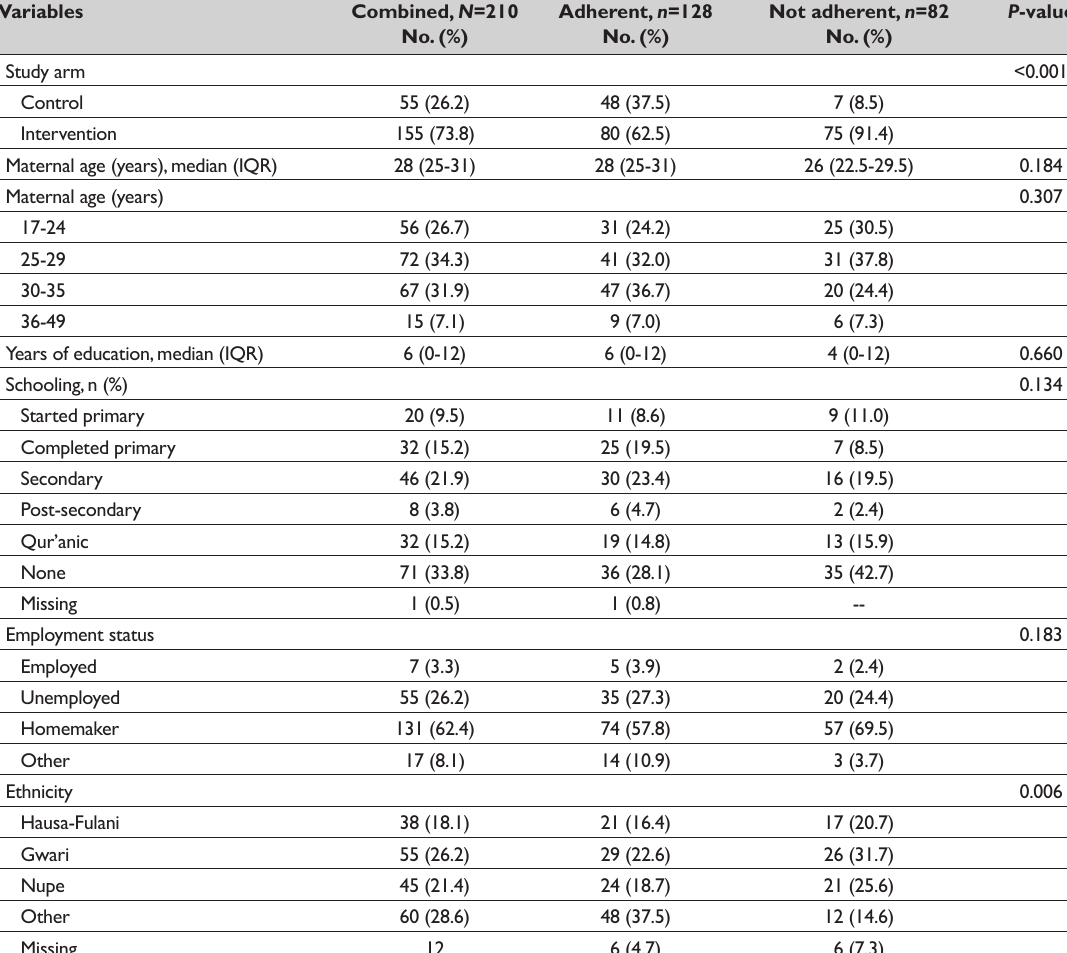
Table 1: Sociodemographic characteristics of study participants by maternal adherence status, Niger state, north central Nigeria